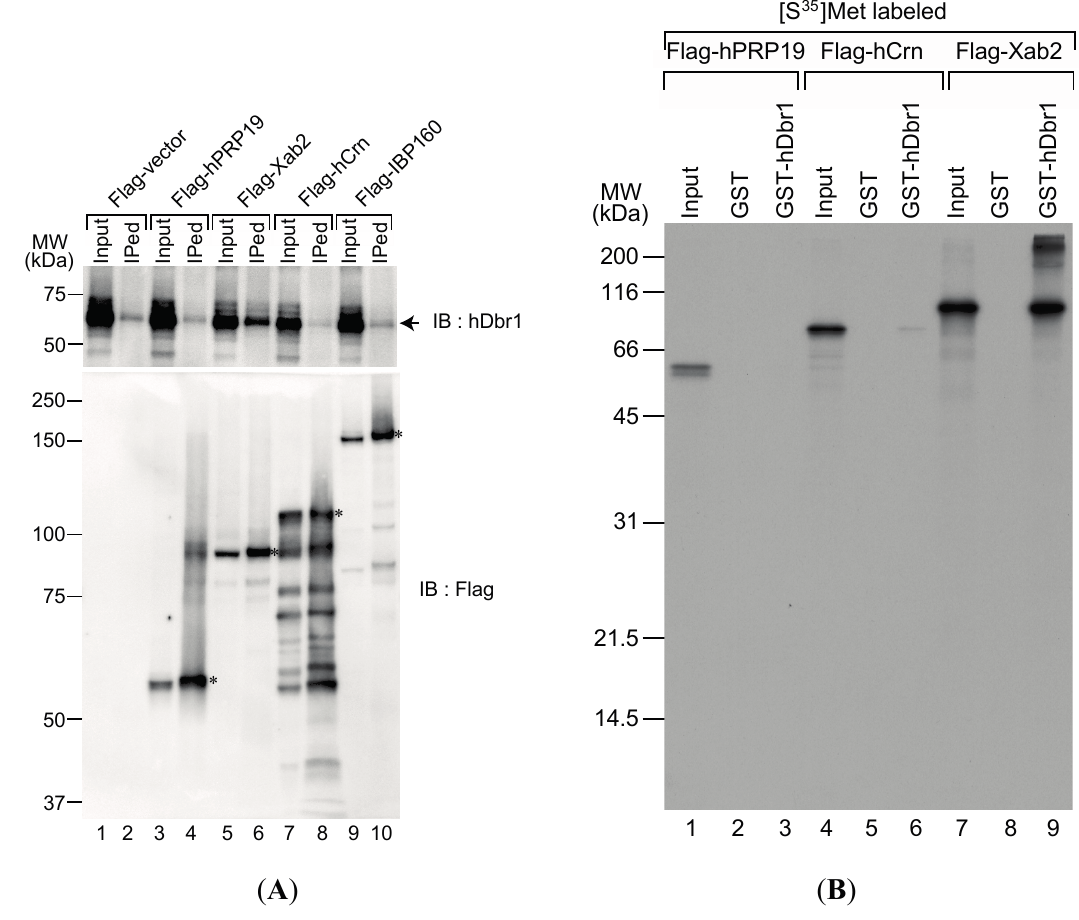
Figure 1. The hDbr1 protein associates with xeroderma pigmentosum, complementeation group A (XPA)-binding protein 2 (Xab2) in vivo and in vitro . ( A ) The in vivo association of several IL complex proteins with hDbr1 protein was analyzed by immunoprecipitation assay. HEK293T whole-cell extract was prepared after transfection with Flag-vector, Flag-hPrp19, Flag-Xab2, Flag-hCrn or Flag-IBP160 plasmid. Flag-tagged proteins were precipitated using anti-Flag M2 agarose from whole-cell extract, and the precipitates (IPed) were subjected to Western blotting analyses using anti-hDbr1 antibody ( upper panel) and an anti-Flag polyclonal antibody ( lower panel). A portion (5%) of the precipitated proteins (lanes marked as Input) was also immunoblotted. The position of endogenous hDbr1 protein is indicated by an arrow in the upper panel. The full-length Flag-tagged proteins are marked with asterisks in the lower panel. The positions of the protein size markers are described on the left of the panel; and ( B ) In vitro binding of hDbr1 to Xab2. Flag-tagged hPrp19, hCrn and Xab2 proteins, produced and labeled with [ 35 S]methionine in vitro , were incubated with 5 μ g each of GST or GST-hDbr1. After precipitation and washing, bound proteins were eluted, separated on 12.5% SDS-PAGE gel and visualized by fluorography. The lanes marked Input contain 10% of the total protein used in each binding reaction. The position of molecular mass markers is shown on the left of the